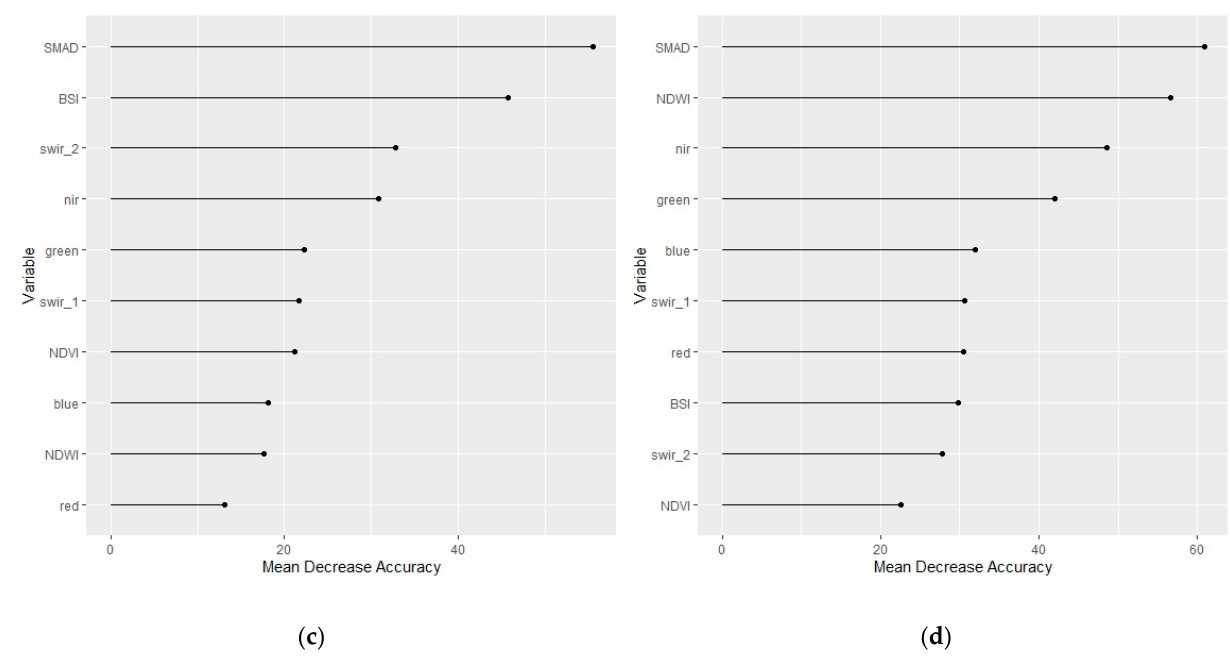
Figure 4. Variable importance expressed as mean decrease in accuracy for the random forest classification models on annual datasets, shown in Figure 3, for ( a ) Ord River Irrigation Area, ( b ) Silalatshani, ( c ) Nabusenga, and ( d ) Lungwalala.